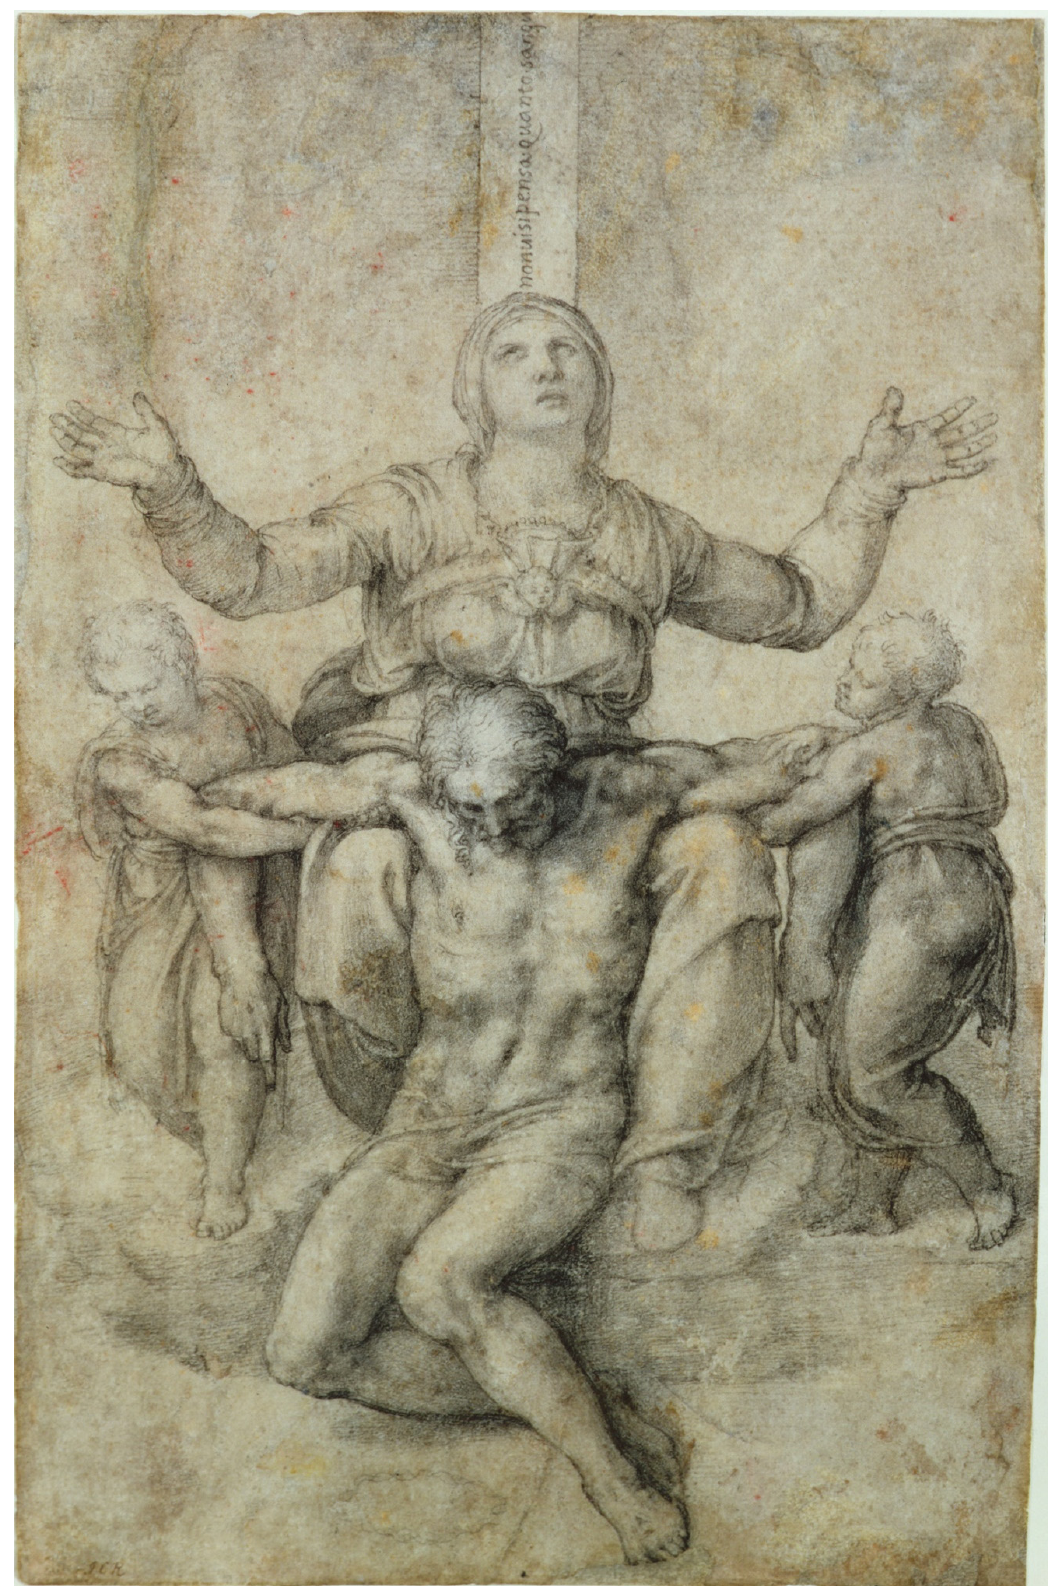
Figure 8. Michelangelo, Pietà for Vittoria Colonna , 1538–1544. Drawing. Boston, Isabella Stewart Gardner Museum, U.S. Image Courtesy of the Isabella Stewart Gardner Museum, Boston, US.